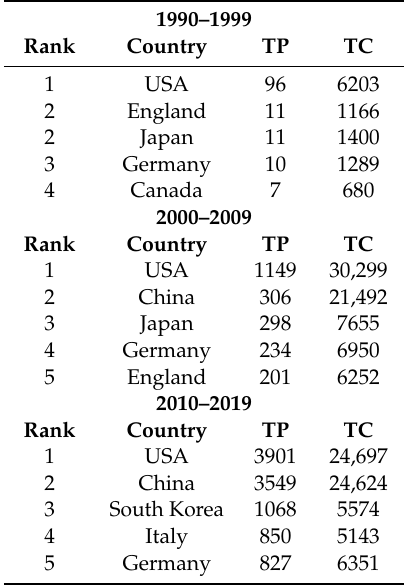
Table 1. Most productive and influential countries throughout time for Set 1.